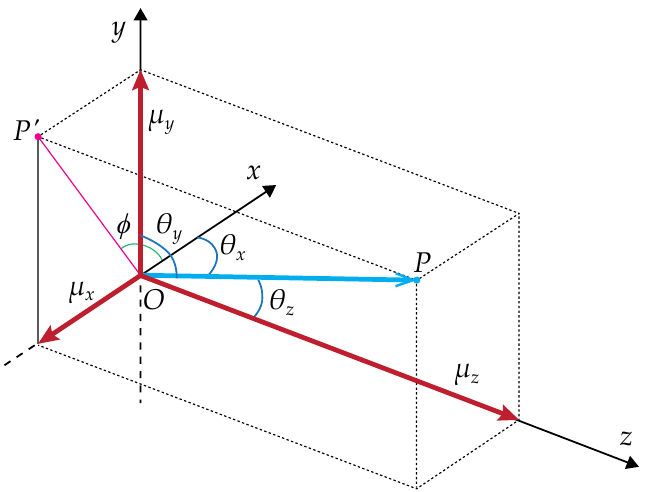
Figure 3. Scheme of direction cosines. The blue vector depicts the photon’s direction vector, and the red vectors ( µ x , µ y , µ z ) are the projections of the photon’s direction vector onto the x , y , and z